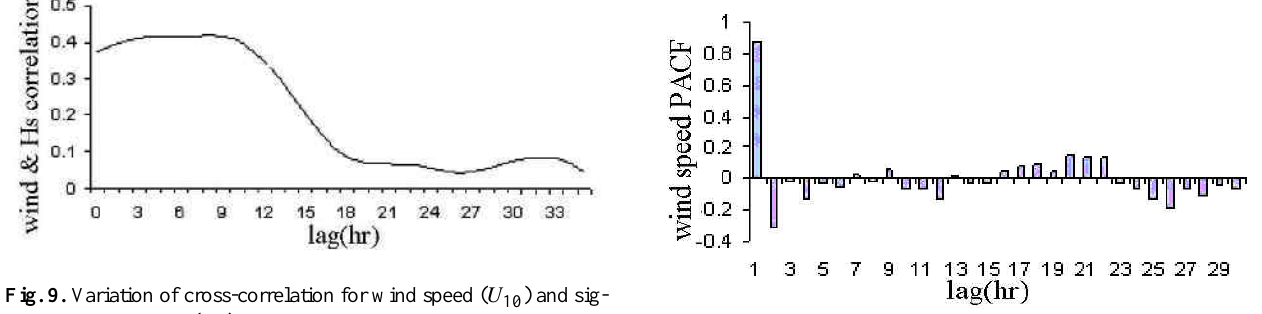
Figure11. Predicted (solid line) and measured (dotted line) wind speed(U 4.5 )